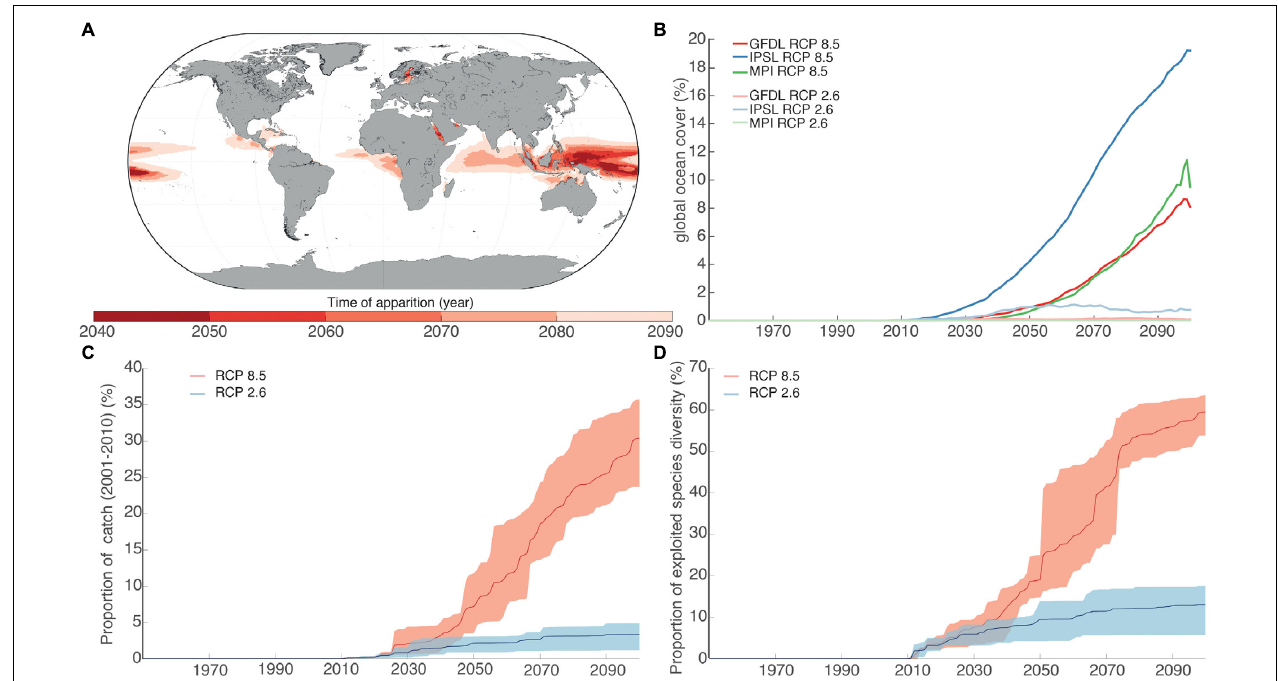
FIGURE 4 | (A) Spatial distribution of the average time of appearance of the NABS across ESMs under RCP 8.5. (B) Evolution of the global coverage of the NABS for the three ESMs and two RCPs. (C) Proportion of global fisheries catches (sum of catch between 2001 and 2010) located in the NABS regions for the period 1970–2100. Interval of confidence computed using the three different ESMs. Thick line represents the median across ESMs. (D) Proportion of the number of species in the NABS for the period 1970–2100. Interval of confidence computed using the three different ESMs. Thick line represents the median across